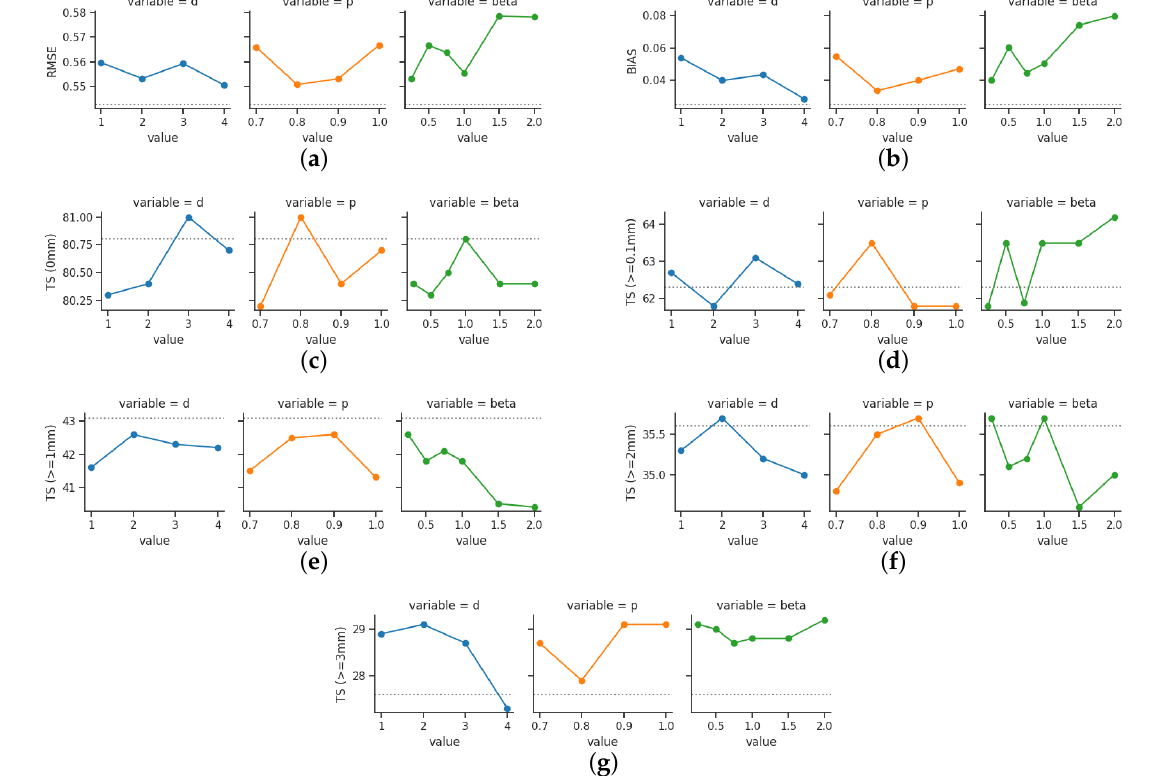
Figure 10. The effect of factors ( d , p , and β (beta) in Equation (12)) in regression focal loss on the model performance. ( a – g ) represents RMSE, bias, TS (0 mm), TS ( ≥ 0.1 mm/ 6min), TS ( ≥ 1 mm/ 6min), TS ( ≥ 2 mm/6 min), TS ( ≥ 3 mm/6 min), respectively. Gray dotted horizontal lines indicate the performance of the weighted model without using RF loss. The default of d , p , and β are 2, 0.9, and 0.25,